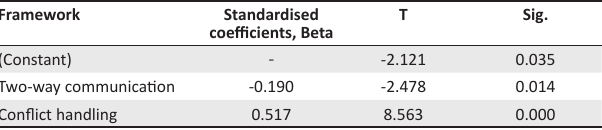
TABLE 3b: Influence of the independent variables on customer relationship management. Framework